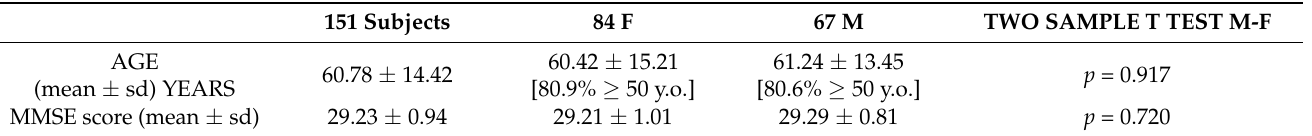
Table 1. Subject